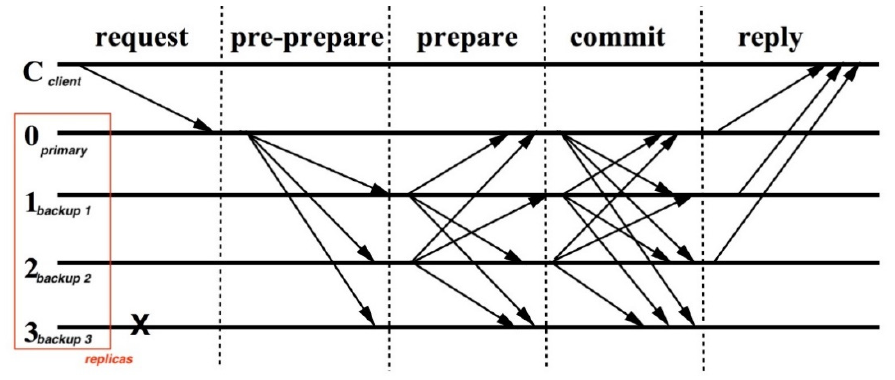
Figure 4. Operation phases of pBFT